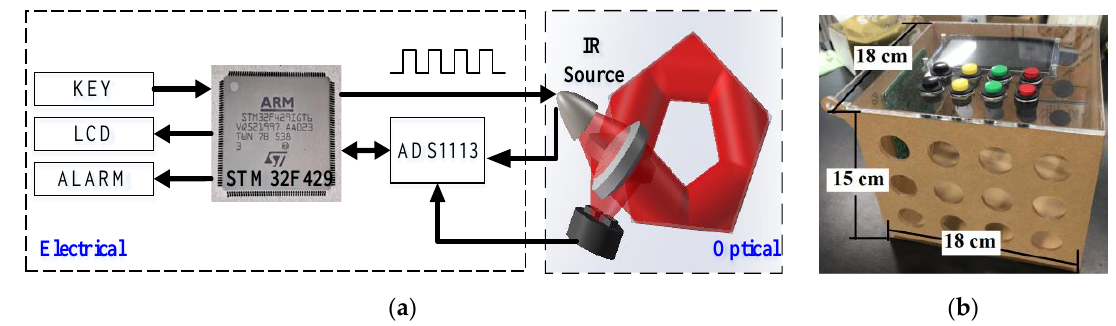
Figure 4. ( a ) Schematic diagram of the NDIR CH 4 sensor, including an electrical and an optical part and ( b ) photo of the sensor.